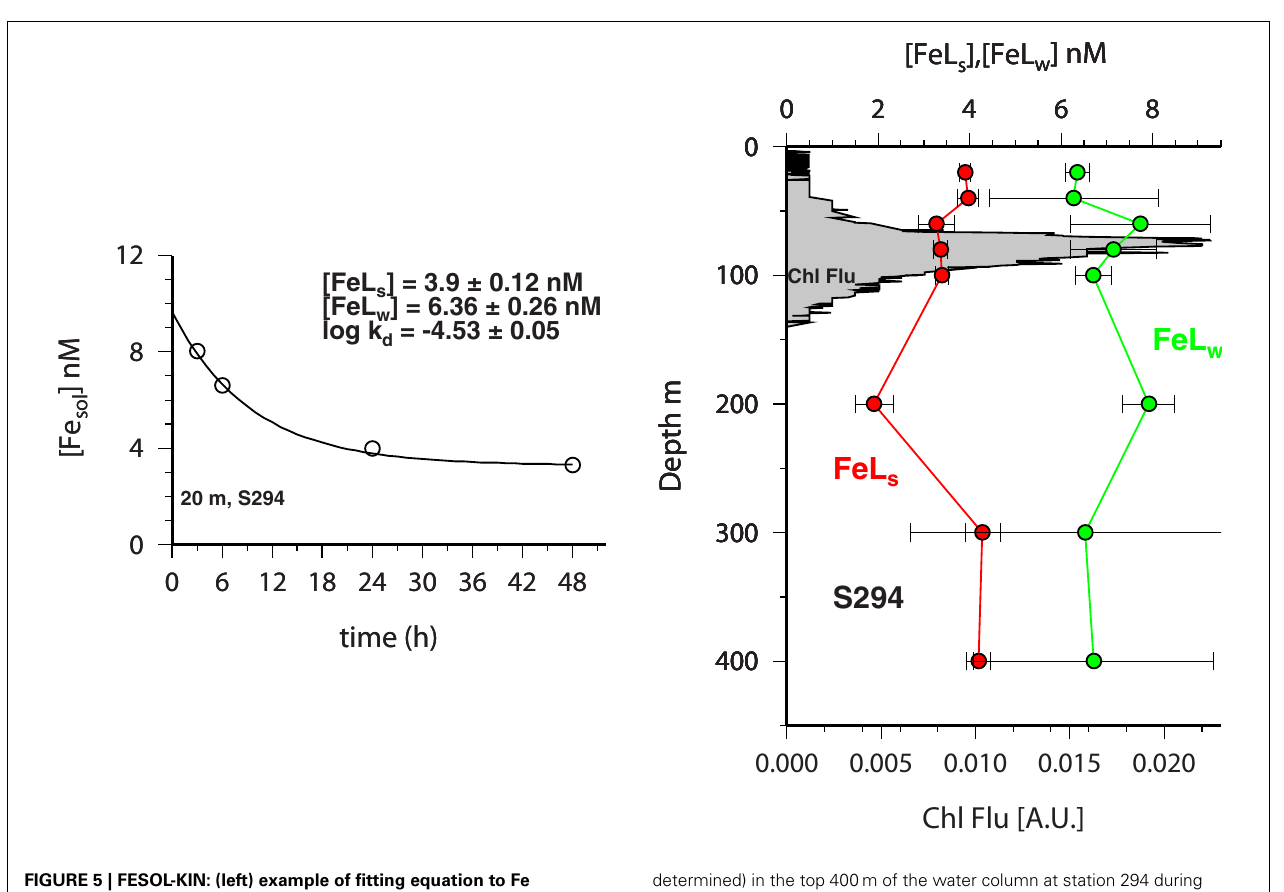
FIGURE 5 | FESOL-KIN: (left) example of fitting equation to Fe solubility ( < 0.025 µ m) data for sample from 20m depth at S294. (Right)Vertical distribution FeL S and FeL W (see text for details of how